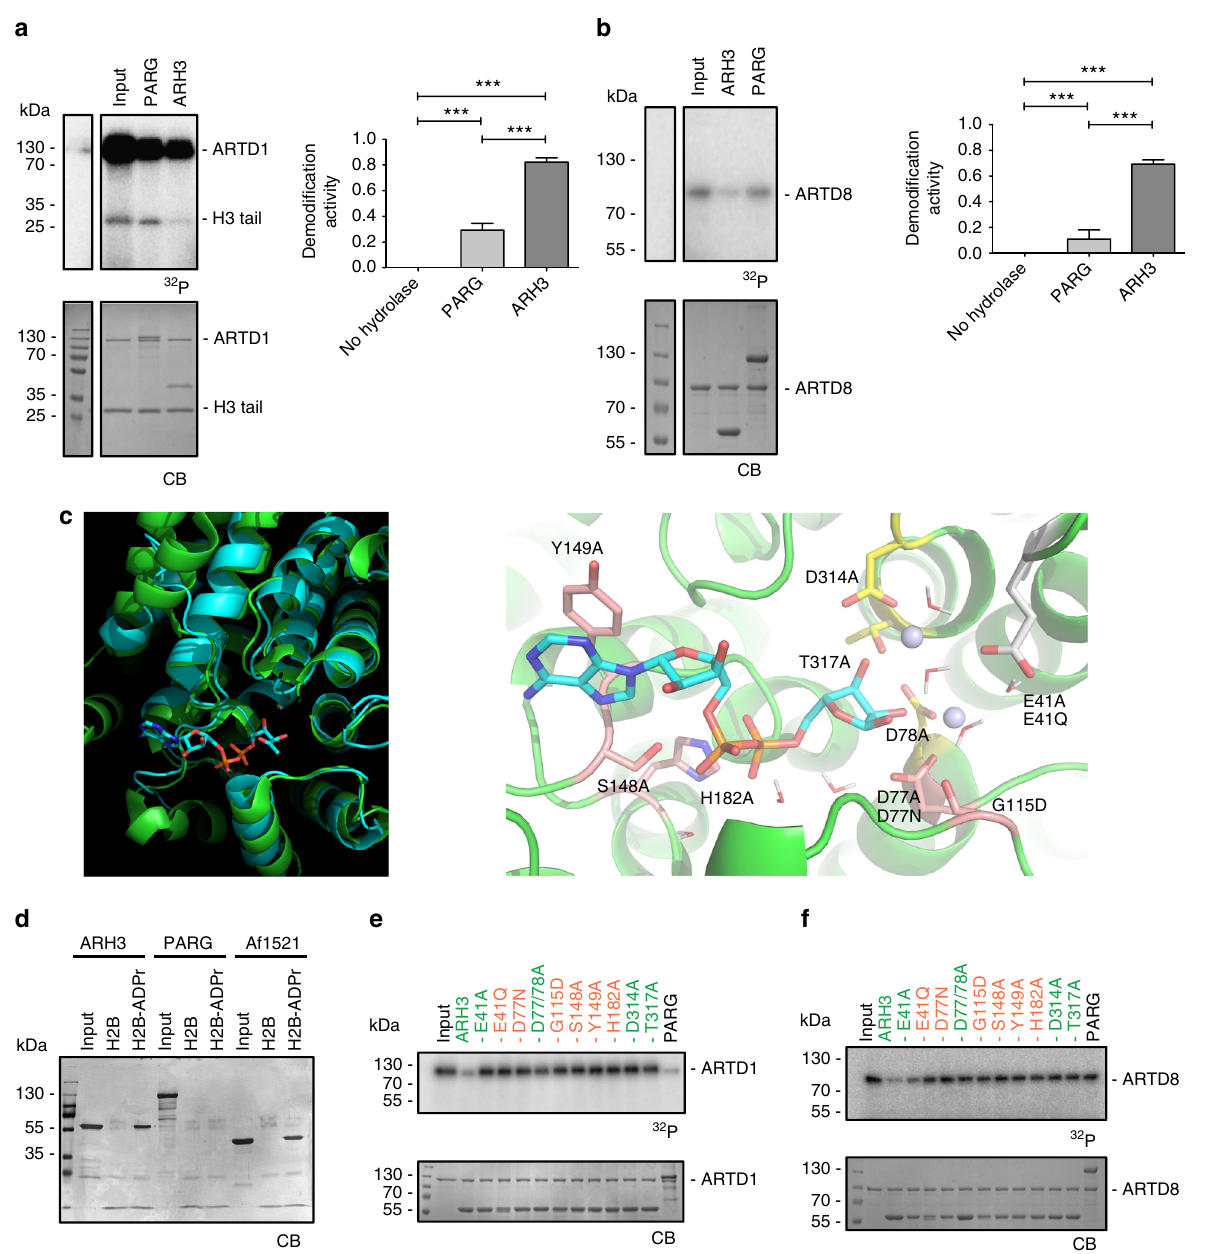
Fig. 1 ARH3 has mono-ARH activity. a Left panel: Recombinant H3 histone tail was in vitro ADP-ribosylated using recombinant ARTD1 in the presence of 32 P-labeled NAD + . Equal fractions were left untreated (Input) or were treated with PARG or ARH3. Above: radioactivity exposure, below: Coomassie Blue- stained poly-acrylamide gel. Right panel: Quanti fi cation of a expressed as demodi fi cation activity ( = reduction of the radioactive signal, normalized to amount of protein). Data represent means ± SEM for n = 3 independent experiments, *** P < 0.0001 as determined by ANOVA. b Left panel: Automodi fi cation of recombinant ARTD8 in the presence of 32 P-labeled NAD + results in MAR-labeled ARTD8 (Input) that was subsequently treated with recombinant PARG or ARH3. Above: radioactivity exposure, below: Coomassie Blue-stained poly-acrylamide gel. Right panel: Quanti fi cation of b expressed as demodi fi cation activity ( = reduction of the radioactive signal, normalized to amount of protein). Data represent means ± SEM for n = 3 independent experiments, *** P < 0.0001 as determined by ANOVA. c Left panel: Structural overlap of human ARH3 (green) and the DraG/ADPr complex (cyan). Right panel: Zoom in the active site of ARH3 with side chains of key residues which were mutated (labels). The binding mode of ADPr (carbon atoms in cyan) was obtained by energy minimization starting from the pose obtained by the structural overlap. d Coomassie Blue-stained membrane of pull-downs of GST-ARH3 (left) or His-PARG using the biotinylated peptides with (H2B-ADPr) and without (H2B) modi fi cation. Af1521 served as positive control. e ARTD1 automodi fi ed in the presence of 32 P-labeled NAD + was subjected to demodi fi cation using WT and different ARH3 mutants. Red labels: mutants de fi cient in binding to H2B-ADPr, green labels: mutants retaining binding to H2B-ADPr. f ARTD8 automodi fi ed in the presence of 32 P-labeled NAD + was subjected to demodi fi cation using WT and different ARH3 mutants. Red labels: mutants de fi cient in binding to H2B-ADPr, green labels: mutants retaining binding to